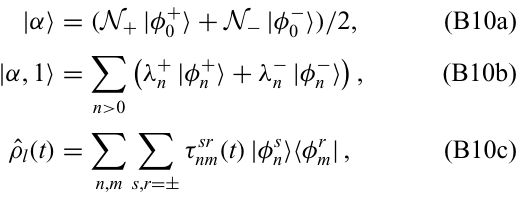
FIG. 14. Energy-level spacing between even and odd parity eigenstates of the Kerr Hamiltonian δ n = | e − K . Similar plot as in Fig. 2(a) but with a logarithmic scale on the vertical axis.